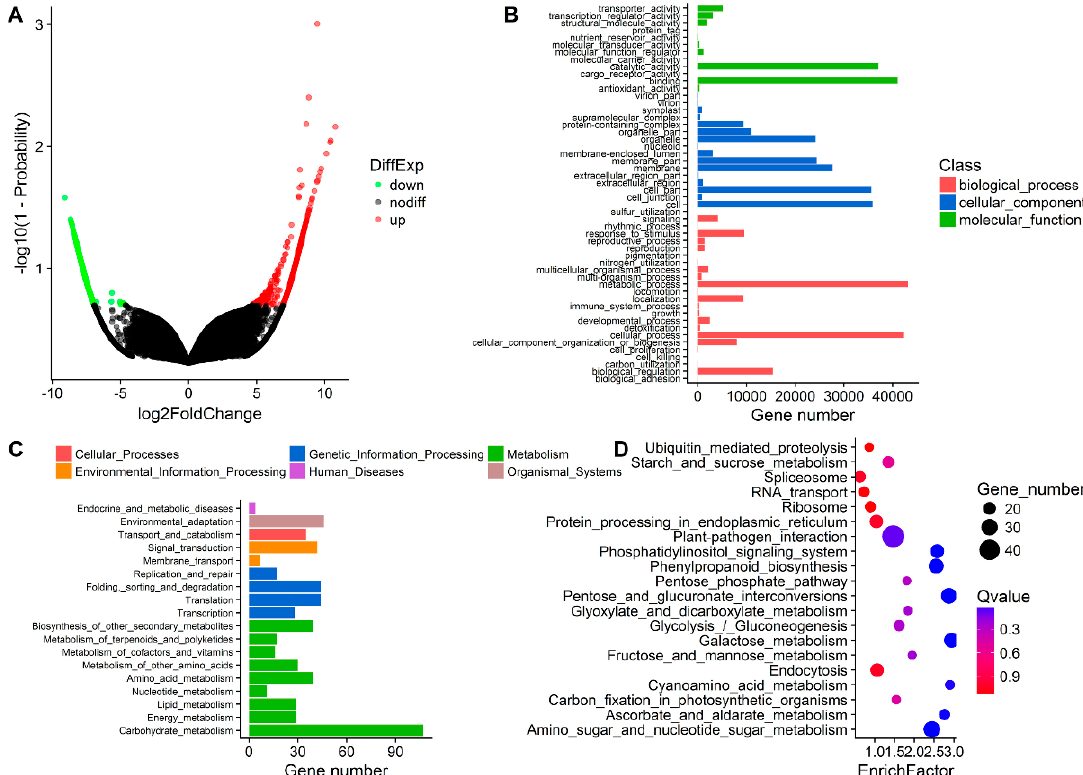
Figure 5. Functional enrichment of differential gene expression profiling in LU and LI. ( A ) Volcanic plot showing differential expression levels. ( B ) GO enrichment of DEGs. ( C ) KEGG pathway levels of DEGs. ( D ) KEGG enrichment of DEGs.